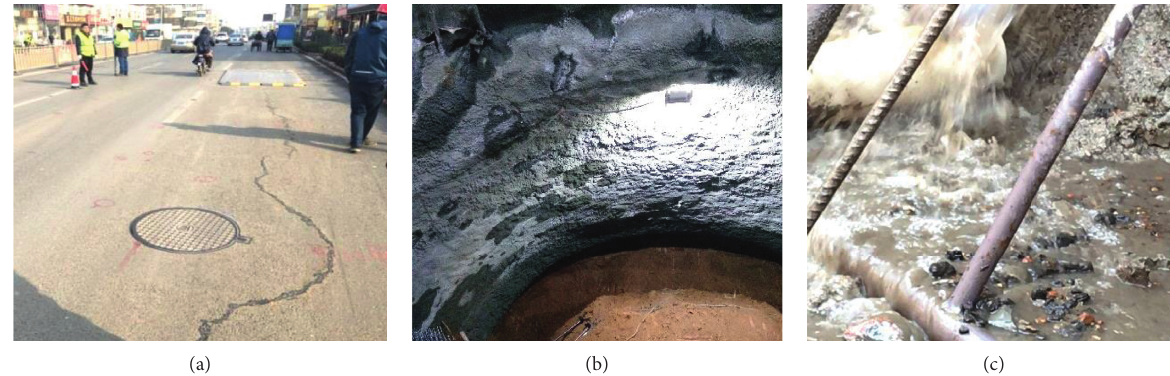
Figure 2: Overburden collapse process for the Yuhan Road urban underground tunnel. (a) Pavement cracks. (b) Partial seepage. (c) Pipeline rupture.